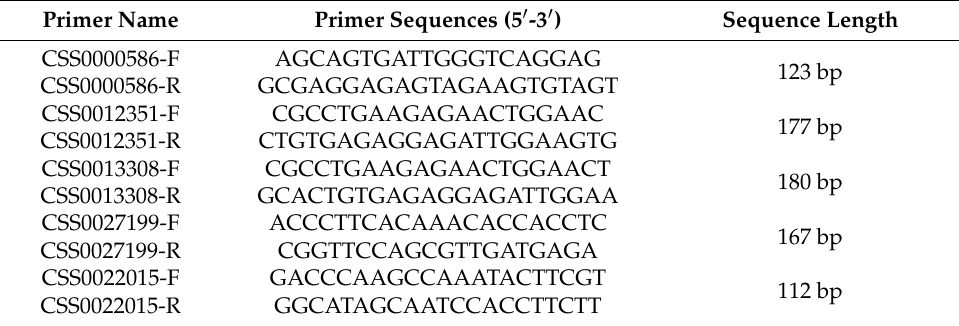
Table 2. Primers for the qRT-PCR analysis of differentially expressed